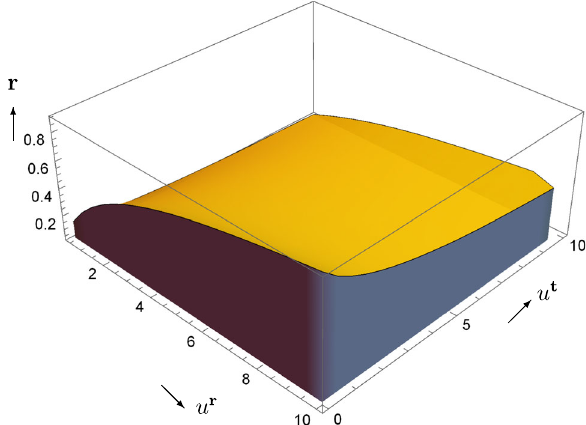
Fig. 3 Entanglement shade for a Rindler wedge in AdS 3 , in the range 0 < u t < 10, 0 < u r < 10, having chosen the parametrization λ = x (which implies u x = 1). The shaded region indicates the radial depths that cannot be penetrated by geodesics with the indicated tangent vector u , or with any other vector U obtained from it by null alignment ( U = u + n with n · n = n · u = 0). As expected from the analysis in the main text, when we consider larger values of u r , corresponding to steeper curves, the shade grows larger. On the other hand, the figure shows that upon increasing the value of u t the shade is reduced. By symmetry, the radial position where the shade begins is independent of the sign of u t and u r , and of course, it is also independent of the values of t and x